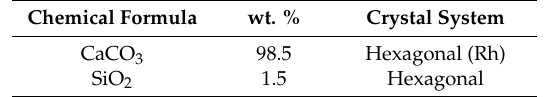
Table 2. X-ray powder diffraction (XRD) analysis of calcite